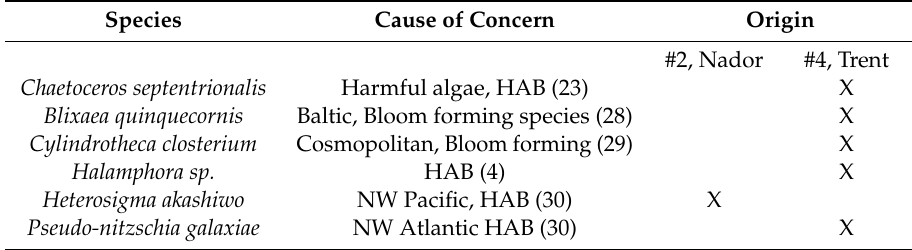
Table 3. HAB species found from eDNA in the ballast water examined (presence marked with X).